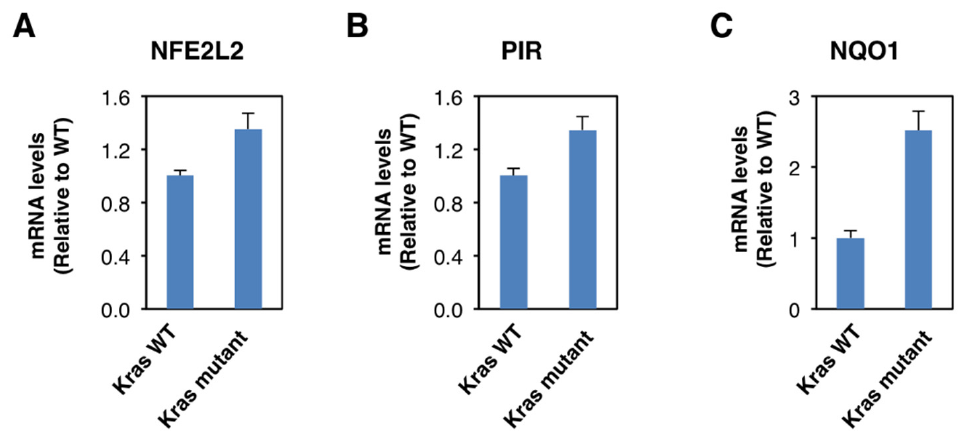
Figure 4. Constitutive activation of K-Ras enhances NFE2L2 transcription. mRNA levels for NFE2L2 ( A ), pirin ( B ), and NQO1 ( C ) in K-Ras WT/ − and K-Ras G13D/ − mutant DLD1 cell lines. p < 0.05 in all cases. The TaqMan data were normalized using eukaryotic 18S rRNA (18S) as an internal control. Curiously however, the expression of the aldo-keto reductase family 1 members AKR1B10 and AKR1C1, which are well-established Nrf2 targets in humans, showed the opposite pattern to that of pirin, Nrf2 and NQO1 in the human tissues. Thus, compared to matched normal tissue, the mRNA levels for AKR1B10 and AKR1C1 were decreased in